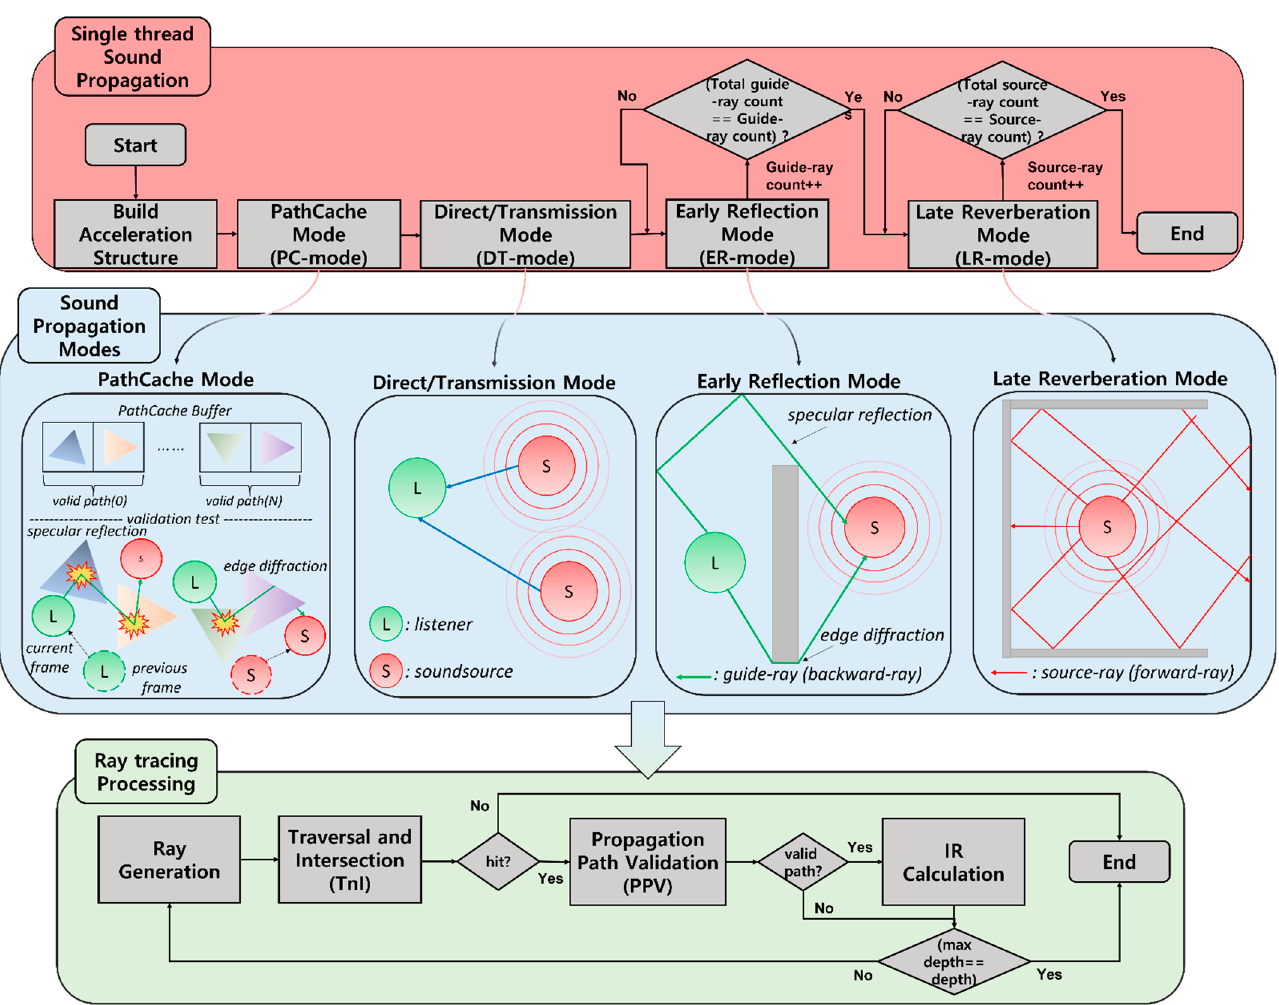
Figure 3. Flowchart of single-threaded sound propagation algorithm ( top ), descriptions of sound propagation modes ( middle ), and ray tracing processing ( bottom ).